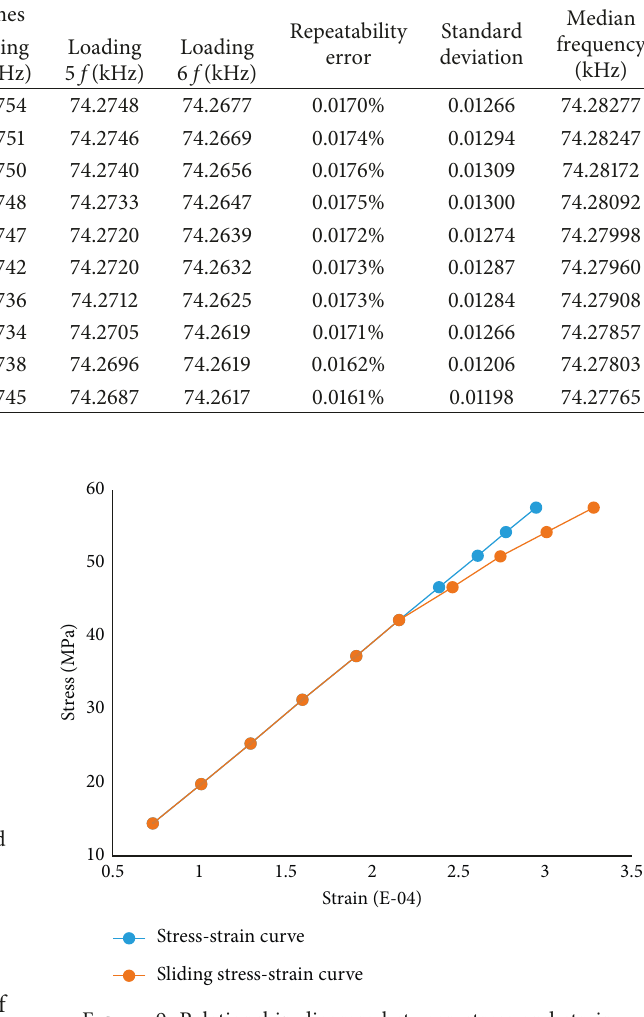
Figure 9: Relationship diagram between stress and strain.